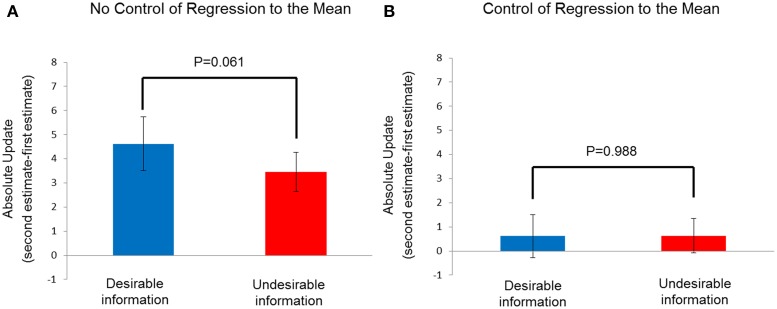
Unrealistic optimism effect in study 2. (A) Absolute update in mean-corrected estimations after 30 min (|mean-corrected 30-min re-estimation - the mean-corrected initial estimation|) as a function of conditions (desirable information vs. undesirable information). (B) Absolute update in mean-corrected estimations after 30 min as a function of conditions. The results were from subsets of events with initial estimations matched between the desirable information and undesirable information conditions, to control for regression to the mean. Error bars indicate standard error.